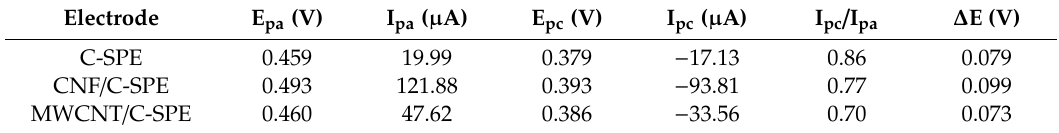
Table 4. The values of the parameters obtained from the cyclic voltammograms of all the electrodes immersed in 10 − 3 M ca ff eic acid solution (the electrolyte support was 0.1 M PBS of pH 3.6).